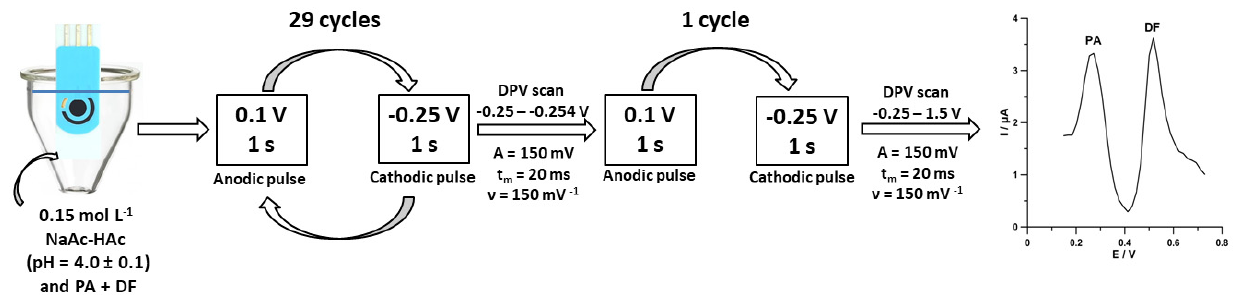
Figure 4. Scheme of voltammetric measurements of PA and DF at the SPCE/MWCNTs-COOH [83].